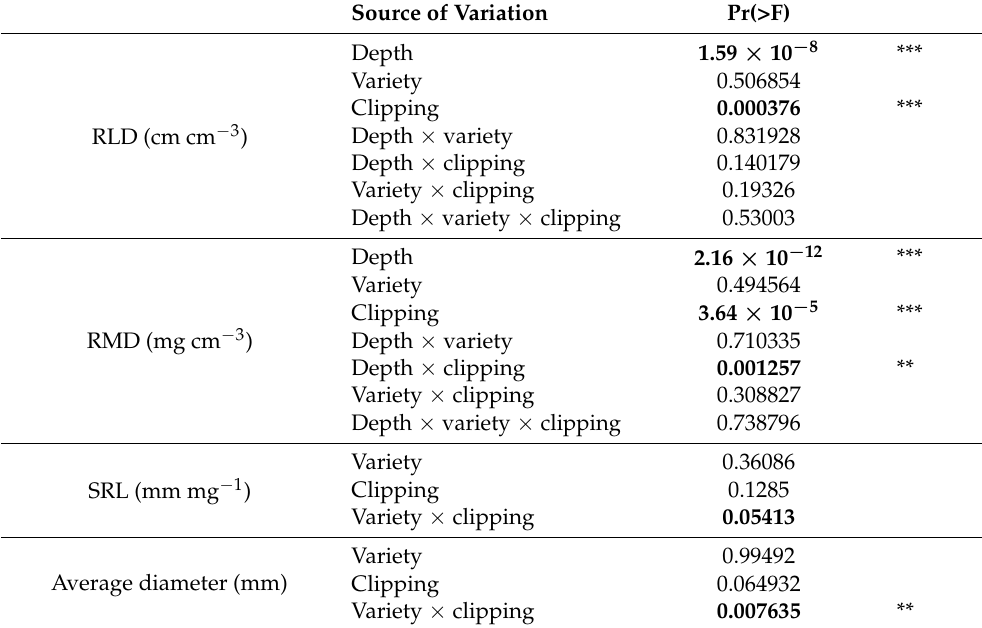
Table 4. Analysis of variance for root traits, p -values < 0.05 are reported in bold. Asterisk depicts factors significance (significance codes: <0.001 ‘***’ 0.01